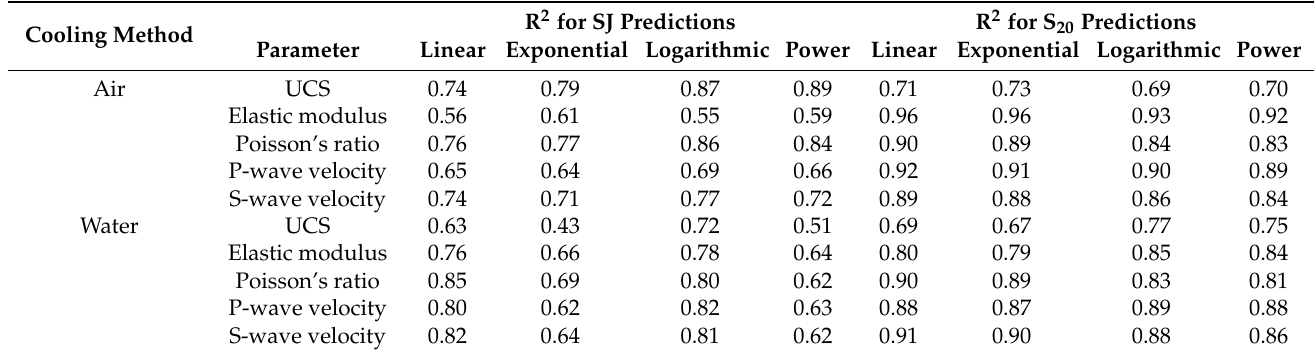
Table 3. Coefficients of determination (R 2 ) for simple regression curves studied to predict SJ and S 20 from mechanical and normalised (N) physical parameters (UCS, elastic modulus, Poisson’s ratio, P- and S-wave velocities). R 2 for SJ Predictions R 2 for S 20 Predictions Cooling Method